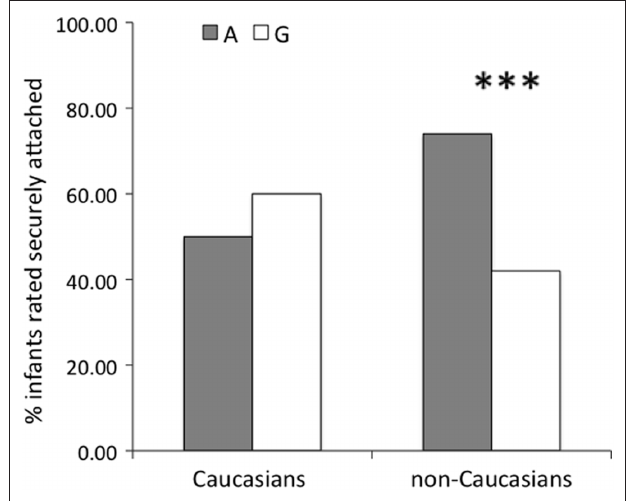
FIGuRe 1 | Percentage of infants classified as secure as a function of rs2254298 genotype and ethnicity. Group A includes infants with the AA or AG genotype. Group G includes infants with the GG genotype. The effect of genotype on attachment security was significant in the non-Caucasian